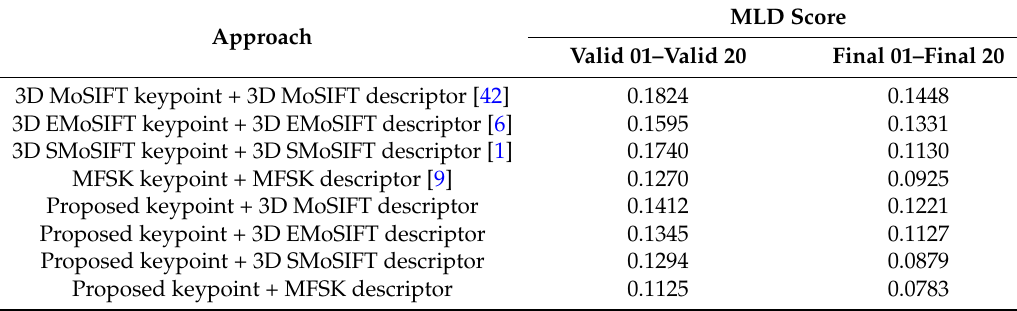
Table 2. The comparison of keypoint detection methods on the validation batch (valid 01–valid 20) and final batch (round 2: final 21–final 40).